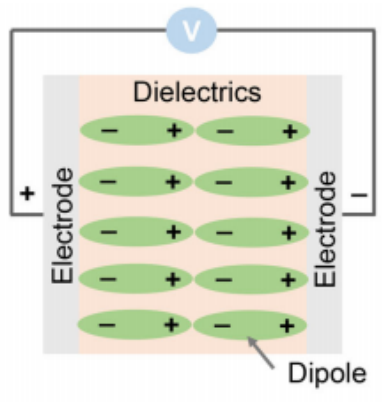
Figure 1. Energy storage mechanism of electric